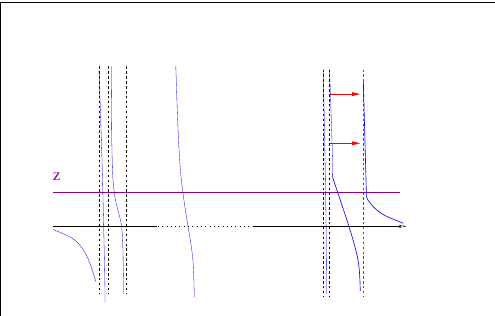
Figure 2: Annealed case: the transition is avoided by detaching an eigenvalue, which stays close ( O ( 1 / N ) ) to the value of z